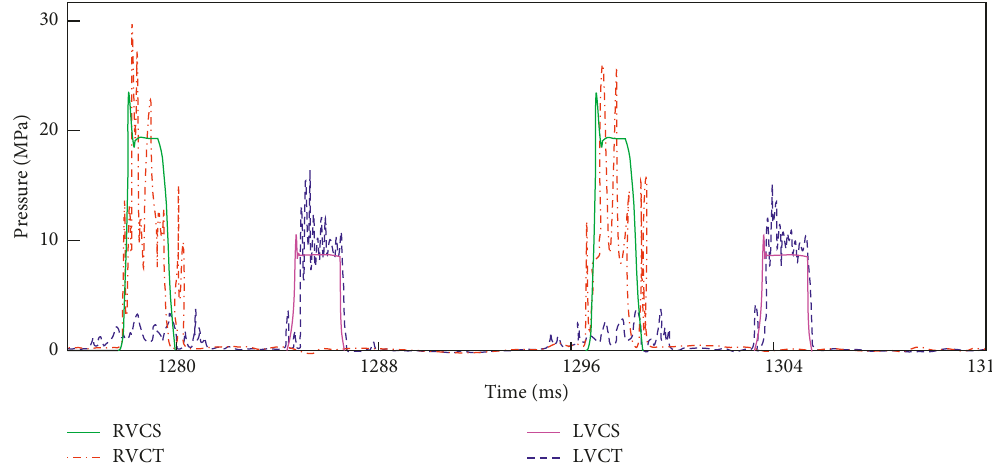
Figure 11: Comparison between simulation and test curves in left and right valve chambers. RVCS: right valve chamber simulation curve; RVCT: right valve chamber testing curve; LVCS: left valve chamber simulation curve; LVCT: left valve chamber testing